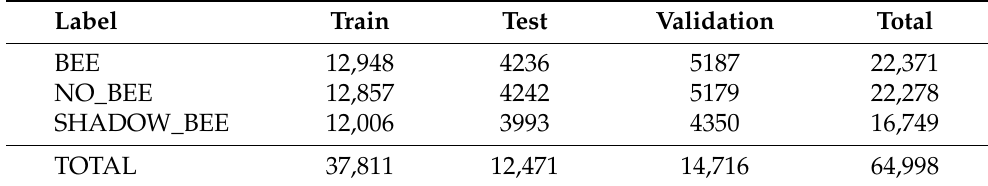
Figure 8. Sample of images from BEE3; first two rows include images classified as BEE; second two rows are images classified as NO_BEE; third three rows are images classified as BEE_SHADOW. Table 10. Numbers of images in BEE3 used for training, testing, and validation.